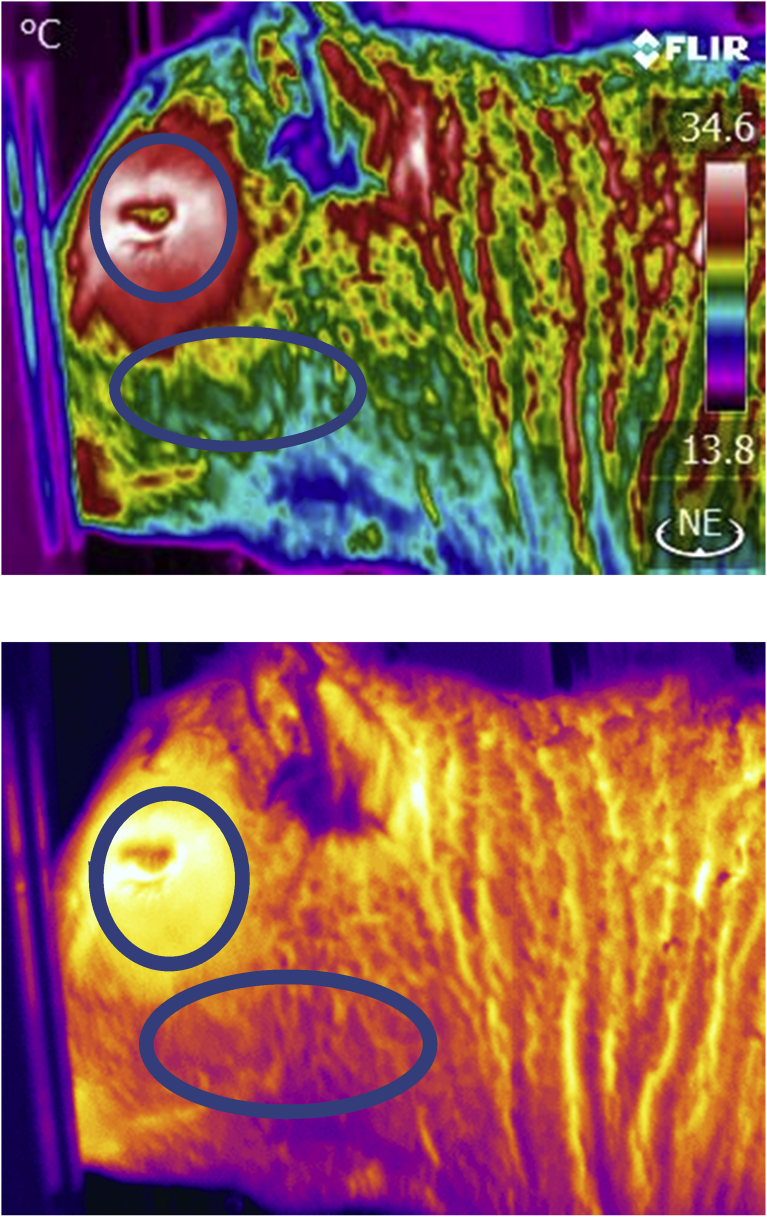
Infrared Thermograph of a steer with a normal eye temperature of 35.9 and normal cheek mean temperature of 28.8 C. Areas scanned are depicted in rainbow palate (top) or lava palate (bottom).